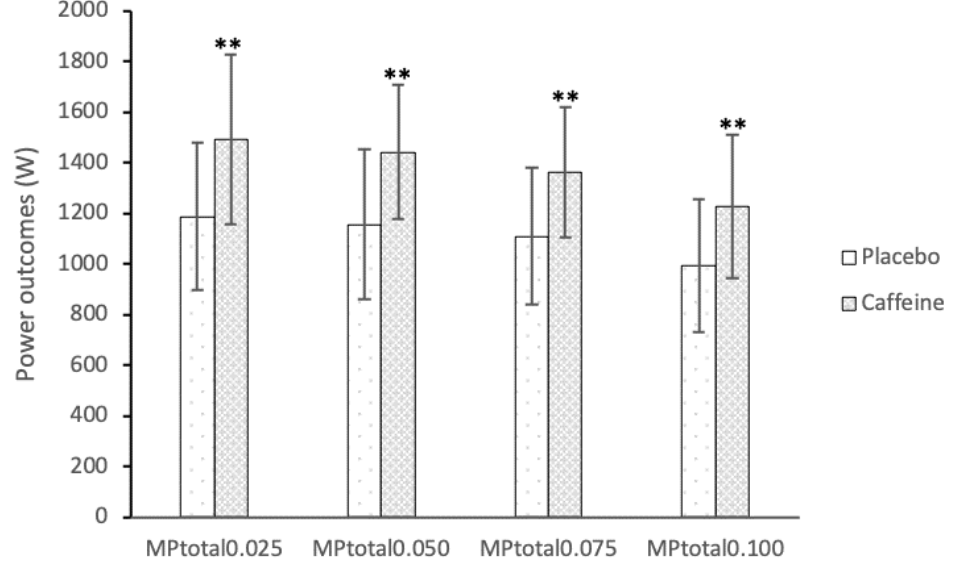
Figure 3. Effects of caffeine ingestion on total mean power (MP total ) outcomes at different inertias when compared to the placebo condition. ** Significant differences ( p < 0.01).